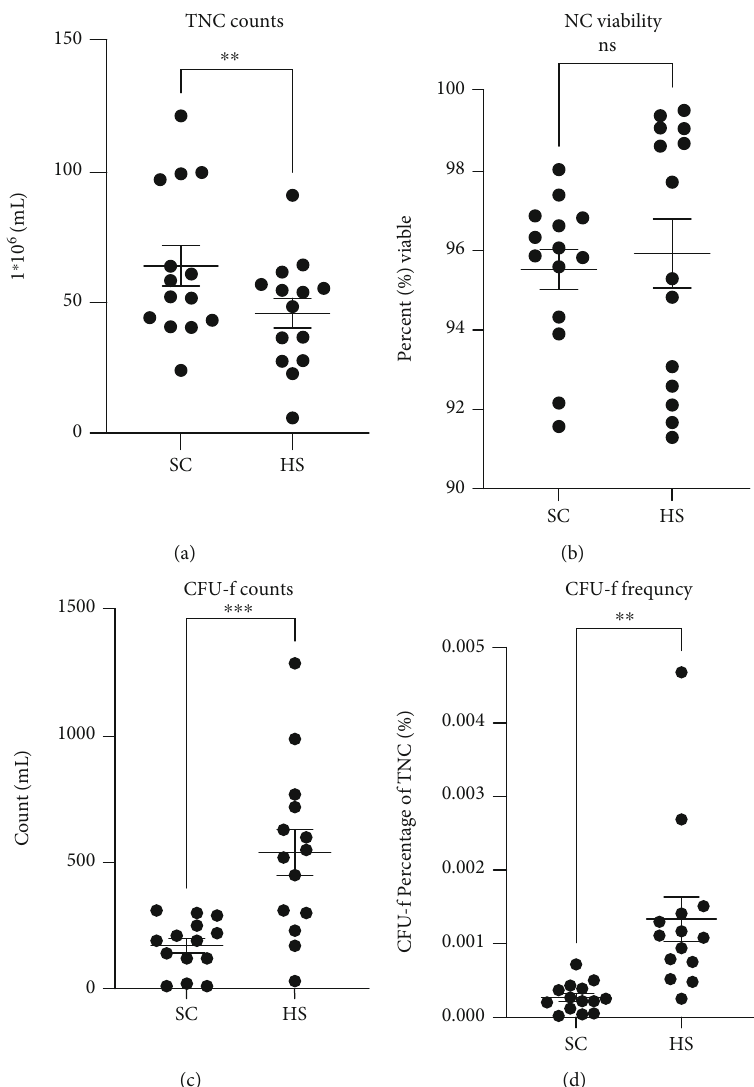
Figure 1: Comparison of BMC characteristics derived from 15% sodium citrate (SC) and 1,000U/mL heparin sodium (HS) (Series 1): (a) total nucleated cell (TNC) count per milliliter, (b) nucleated cell (NC) viability, (c) colony-forming units with fi broblast morphology (CFU-f ) counts per milliliter, and (d) frequency of CFU-f amongst the TNC population. Graphs display the population mean and standard error of the mean. ns: not signi fi cant, ∗ P < 0 : 05 , ∗∗ P < 0 : 01 , and ∗∗∗ P < 0 : 001